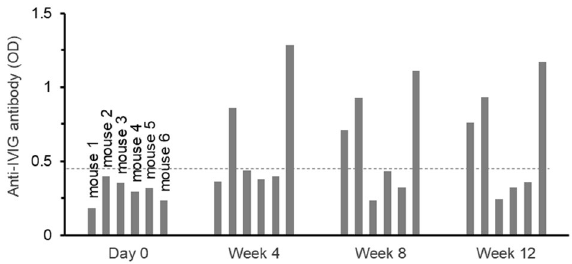
Figure 4. Anti-human IVIG antibody levels of each mouse following co-injection therapy in the treatment group determined by ELISA. Data are presented as the measured OD 405 from the ELISA assay. The dashed line represents the limit of detection, any sample with an OD below that point is considered negative for the presence of anti-IVIG